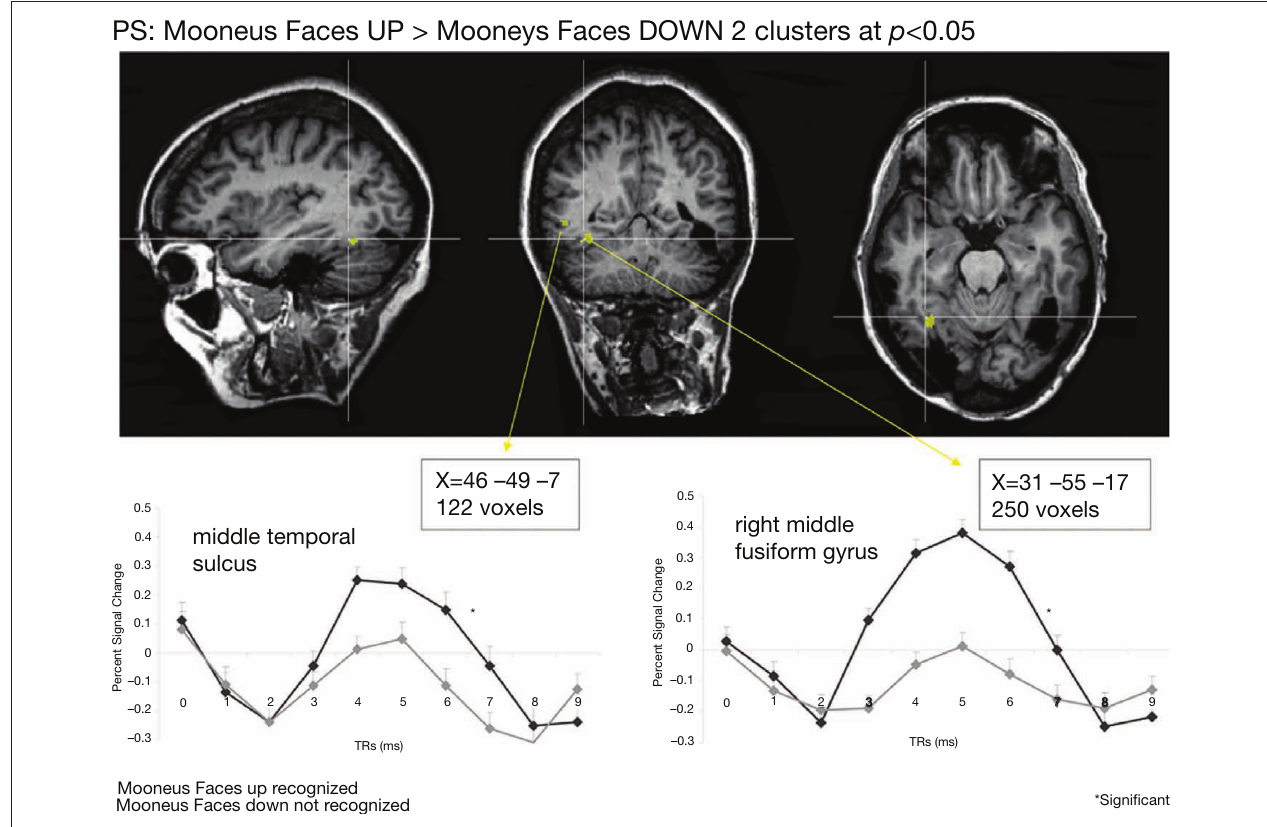
Figure 7 | Whole-brain analysis performed on the patient PS in the Mooney face categorization experiment. Two areas were found to be significant, one corresponding roughly to the patient’s right FFA, presenting face-preferential response to faces in the localizer experiment, and the other one in the middle temporal sulcus, which did not show a preferential response to faces in the localizer